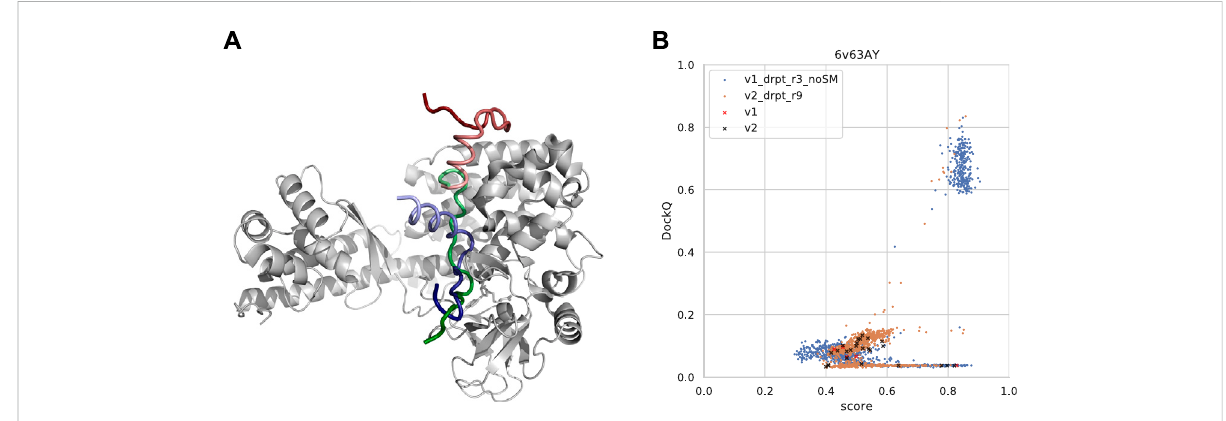
FIGURE 11 (A) An example from the test set where both forced sampling through dropout and combination with the template-based method, InterPep2, can improve the prediction. The predictions are of a cytoplasmic actin peptide binding to actin-histidine N-methyltranferase (PDB ID 6v63). The top predictions by AlphaFold-Multimer positions the very end of the C-terminal in the correct site (top1 prediction in red and native peptide colored green) but positions the peptide in the opposite direction of the actual fold, leading to most of it binding outside the pocket. The prediction by InterPep2 (blue) is coarse with some minor clashes but has positioned the peptide inside the correct binding site. Note how both AlphaFold and InterPep2 have adopted similar folds for the peptide. (B) Scatterplot of AlphaFold-Multimer predicted score versus DockQ for all models generated for the 6v63 complex. When dropout at inference forces increased sampling, some conformations are sampled in the correct binding